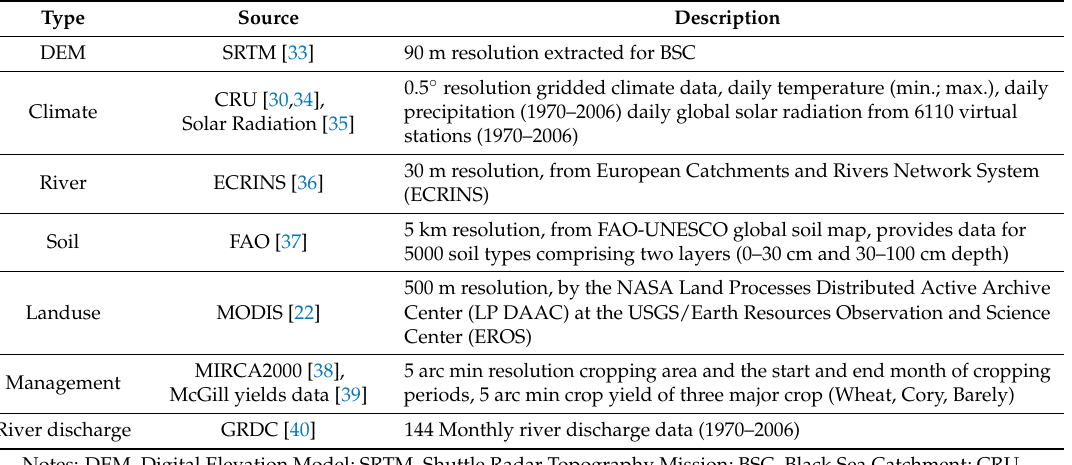
Table 2. Sources of model input data and descriptions for the base model.